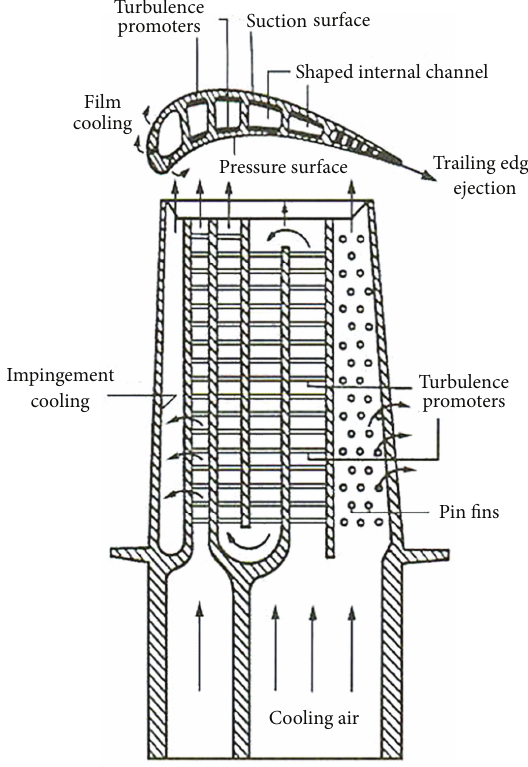
Figure 1: Typical internal cooling arrangement for a multipass turbine blade from Han et al. [2,